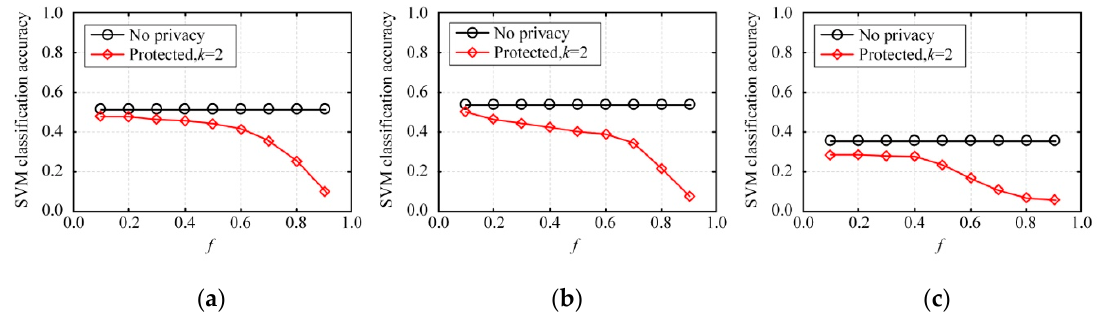
Figure 11. SVM classification accuracy by MeanEST algorithm: ( a ) NLTCS, ( b ) Adults, ( c ) TPC-E.